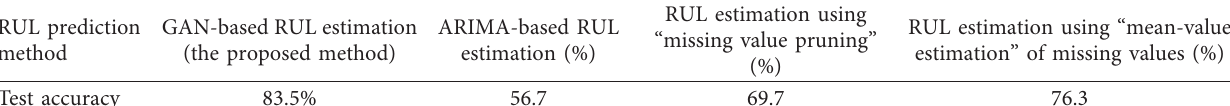
Table 9: Test accuracy for each RUL estimation method (case for fault code ID 31).